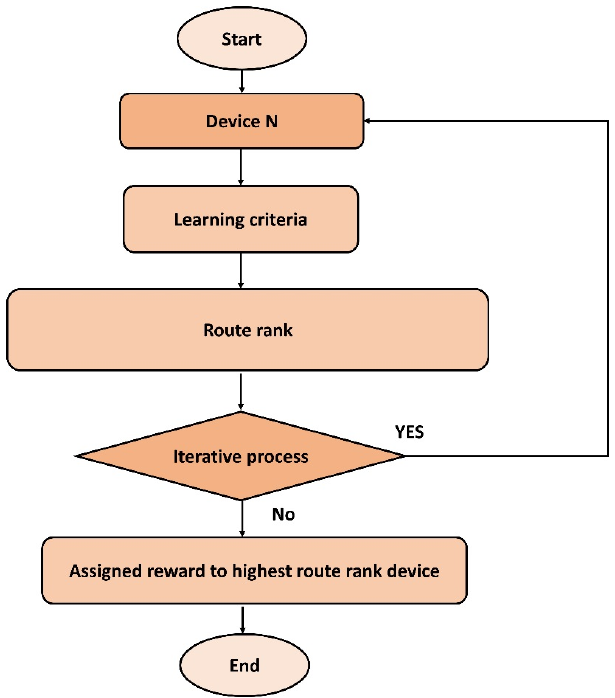
Figure 2. Route rank using reinforcement learning.